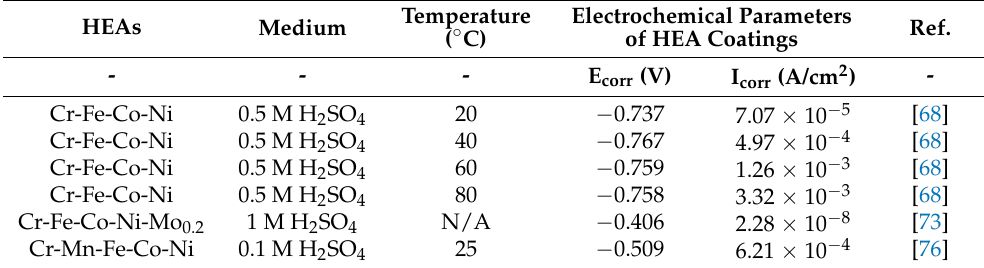
Table 5. The effects of acidic environment (pH < 7) at different temperatures on the corrosion resistance of HEA